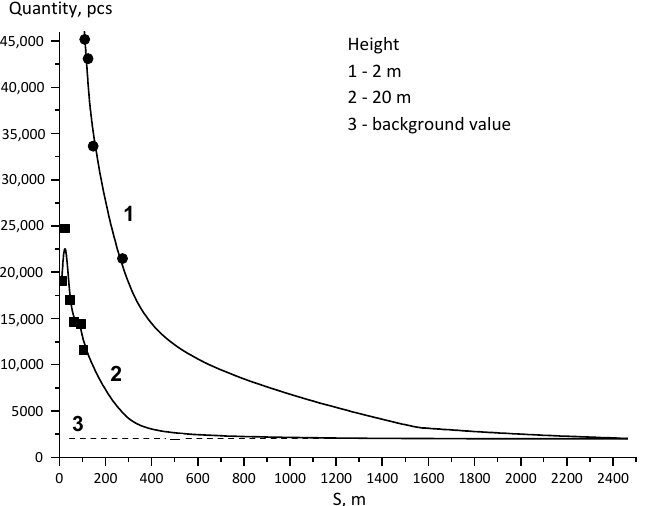
Figure 7. Concentration change of aerosols with a particle diameter of at least 0.3 microns at different heights in comparison with background value.